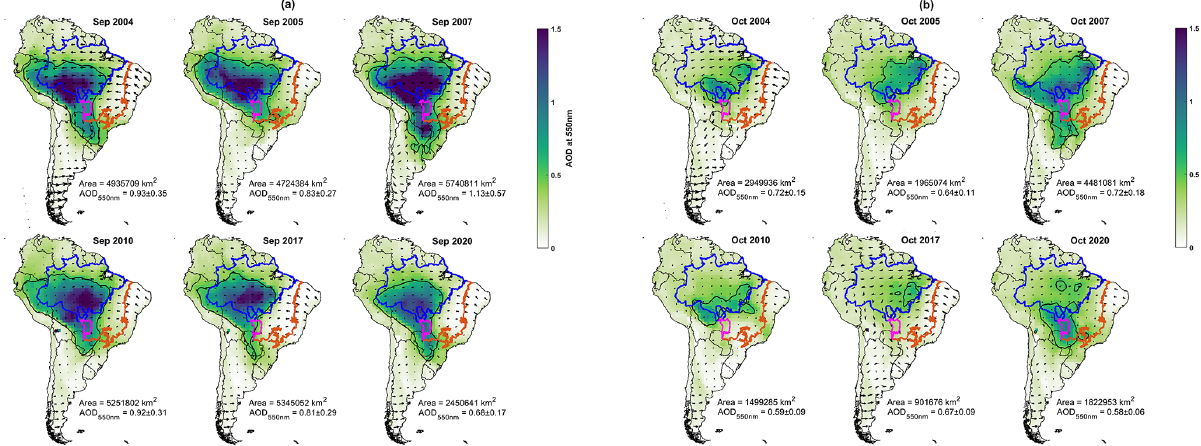
Figure 8. Spatial distribution of the mean aerosol optical depth at 550nm (AOD at 550nm) and wind pattern at 850hPa for September (a) and October (b) of different years. The area limited by the black solid line represents the regions with AOD 550nm higher than 0.5, and its dimension (area) and mean AOD 550nm are also presented. The biome borders are represented by the colors blue (Amazon Rainforest), red (Cerrado ecosystem), and green (Pantanal).